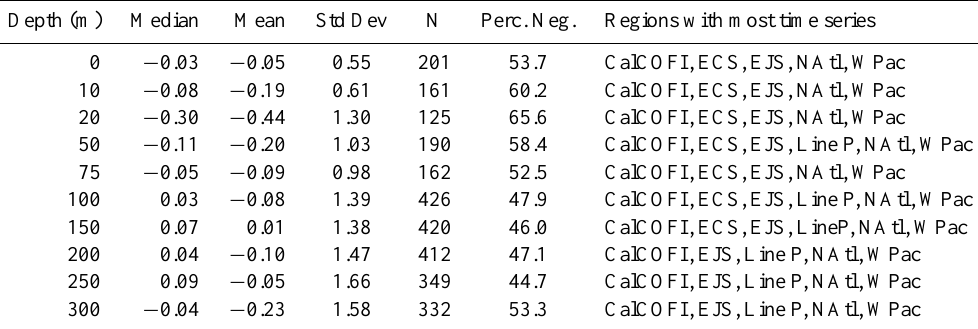
Table 7. Oxygen trend statistics (µmolL − 1 yr − 1 ) calculated from raw data in the open ocean, more than 100km from the shoreline, for the 1976–2000 period. Abbreviations: C. I. = confidence interval; Std Dev = standard deviation; N = number of time series;